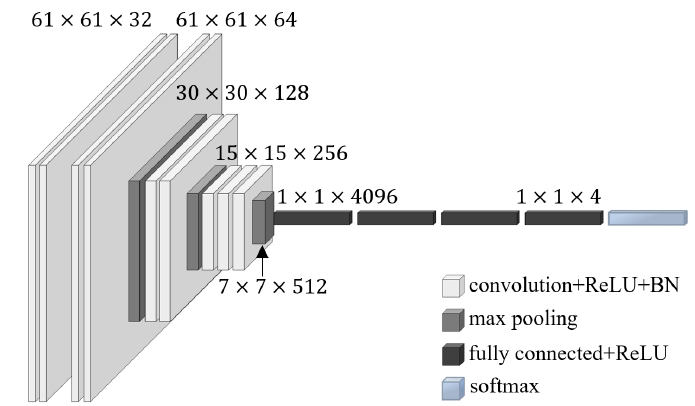
Figure 6. The network structure of improved